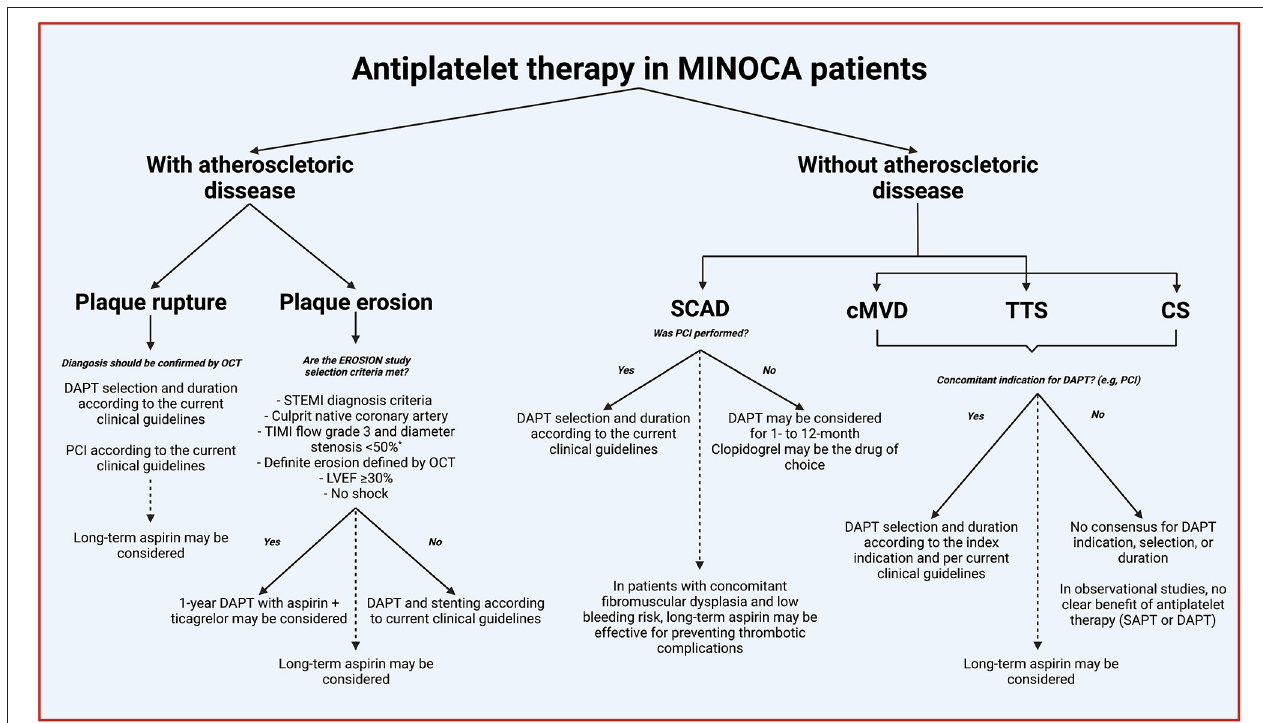
FIGURE 5 | Indications of antiplatelet therapy in patients with MINOCA . Continued lines denoted acute or short-term treatment, and dashed lines indicate long-term (beyond 1-year). *% of coronary diameter of stenosis adapted to match the MINOCA diagnosis criteria. MINOCA, myocardial infarction with non-obstructive coronary arteries; OCT, optical coherence tomography; DAPT, dual antiplatelet therapy; STEMI, ST-segment elevation myocardial infarction; TIMI, Thrombolysis In Myocardial Infarction; EROSION, new in vivo diagnosis and paradigm shift in the treatment of patients with acute coronary syndrome study; LVEF, left ventricular ejection fraction; SCAD, spontaneous coronary artery dissection; PCI, percutaneous cardiac intervention; cMVD, coronary microvascular disease; TTS, Takotsubo syndrome; CS, epicardial coronary spasm; SAPT, single antiplatelet therapy.